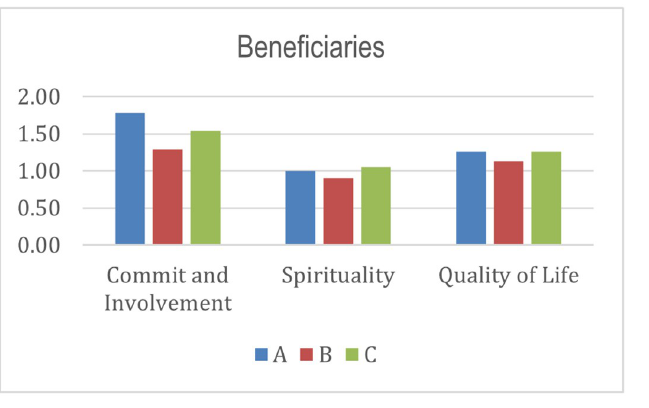
Fig 6. Index score of beneficiaries.